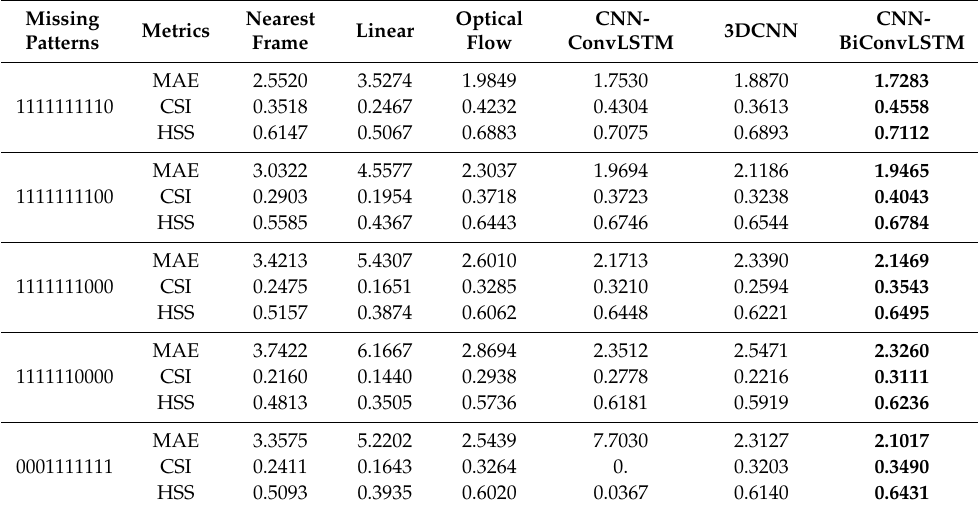
Table 2. Evaluation results of MAE, CSI-40 scores, and HSS scores for the CNN-BiConvLSTM model and baseline models, and for 5 missing patterns with respect to extrapolation. Missing